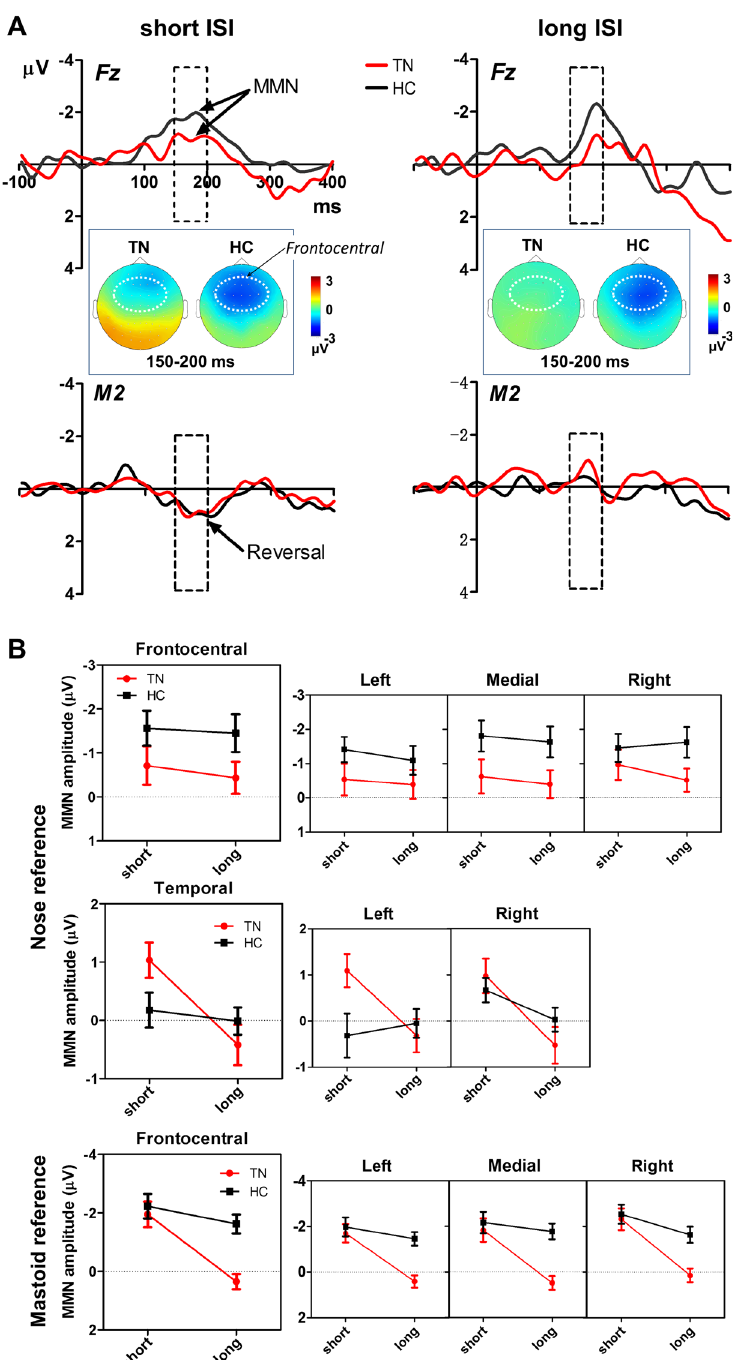
Figure 2. Comparison of MMN amplitudes between TN patients and HCs in different ISI conditions. ( A ) MMN grand average waveforms at frontal and temporal regions shown with scalp topographical maps. The dashed boxes superimposed on waveforms mark the MMN time window (150–200 ms). Scalp topographies of MMN amplitude are shown in this time window, with a white dotted oval indicating the frontocentral ROI. Note the typical negative deflection at Fz and a polarity reversal (positive deflection) at the mastoid. ( B ) Nose- referenced and mastoid re-referenced MMN data at frontocentral and temporal regions. Reduction of MMN amplitude with ISI prolongation was more pronounced in the TN group than in the HC group. Error bars indicate standard